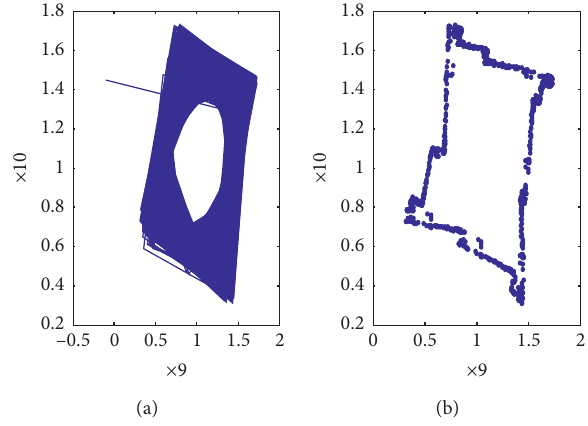
Figure 36: ω � 210 and k when t ∈ 0 . 05 0 . 0597 􏼂 􏼃